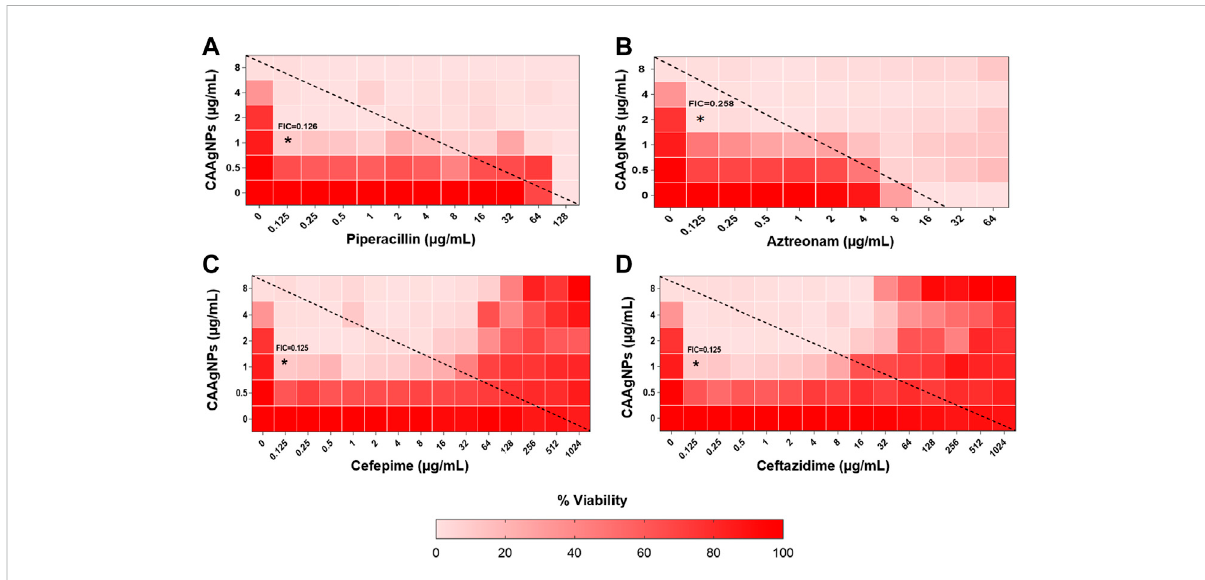
FIGURE 8 Heat plots demonstrating synergistic effect of CAAgNPs in combination with antibiotics against P. aeruginosa PAW1. Representation of normalized values ofpercentviabilityafter treatmentofCAAgNPs (0 – 8 μ g/ml) with (A) Piperacillin (0 – 128 μ g/ml), (B) Azetreonam(0 – 64 μ g/ml), (C) Cefepime (0 – 1,024 μ g/ml) and (D) ceftazidime (0 – 1,024 μ g/ml) respectively. Untreated cells with hundred percent viability indicated by darker red boxes.Lighter redboxesindicatereducedcellviability.DashedlinepassesthroughtheMICsand “ * ” (asterisk)belowitrepresentstheFICivalues suggesting a synergistic